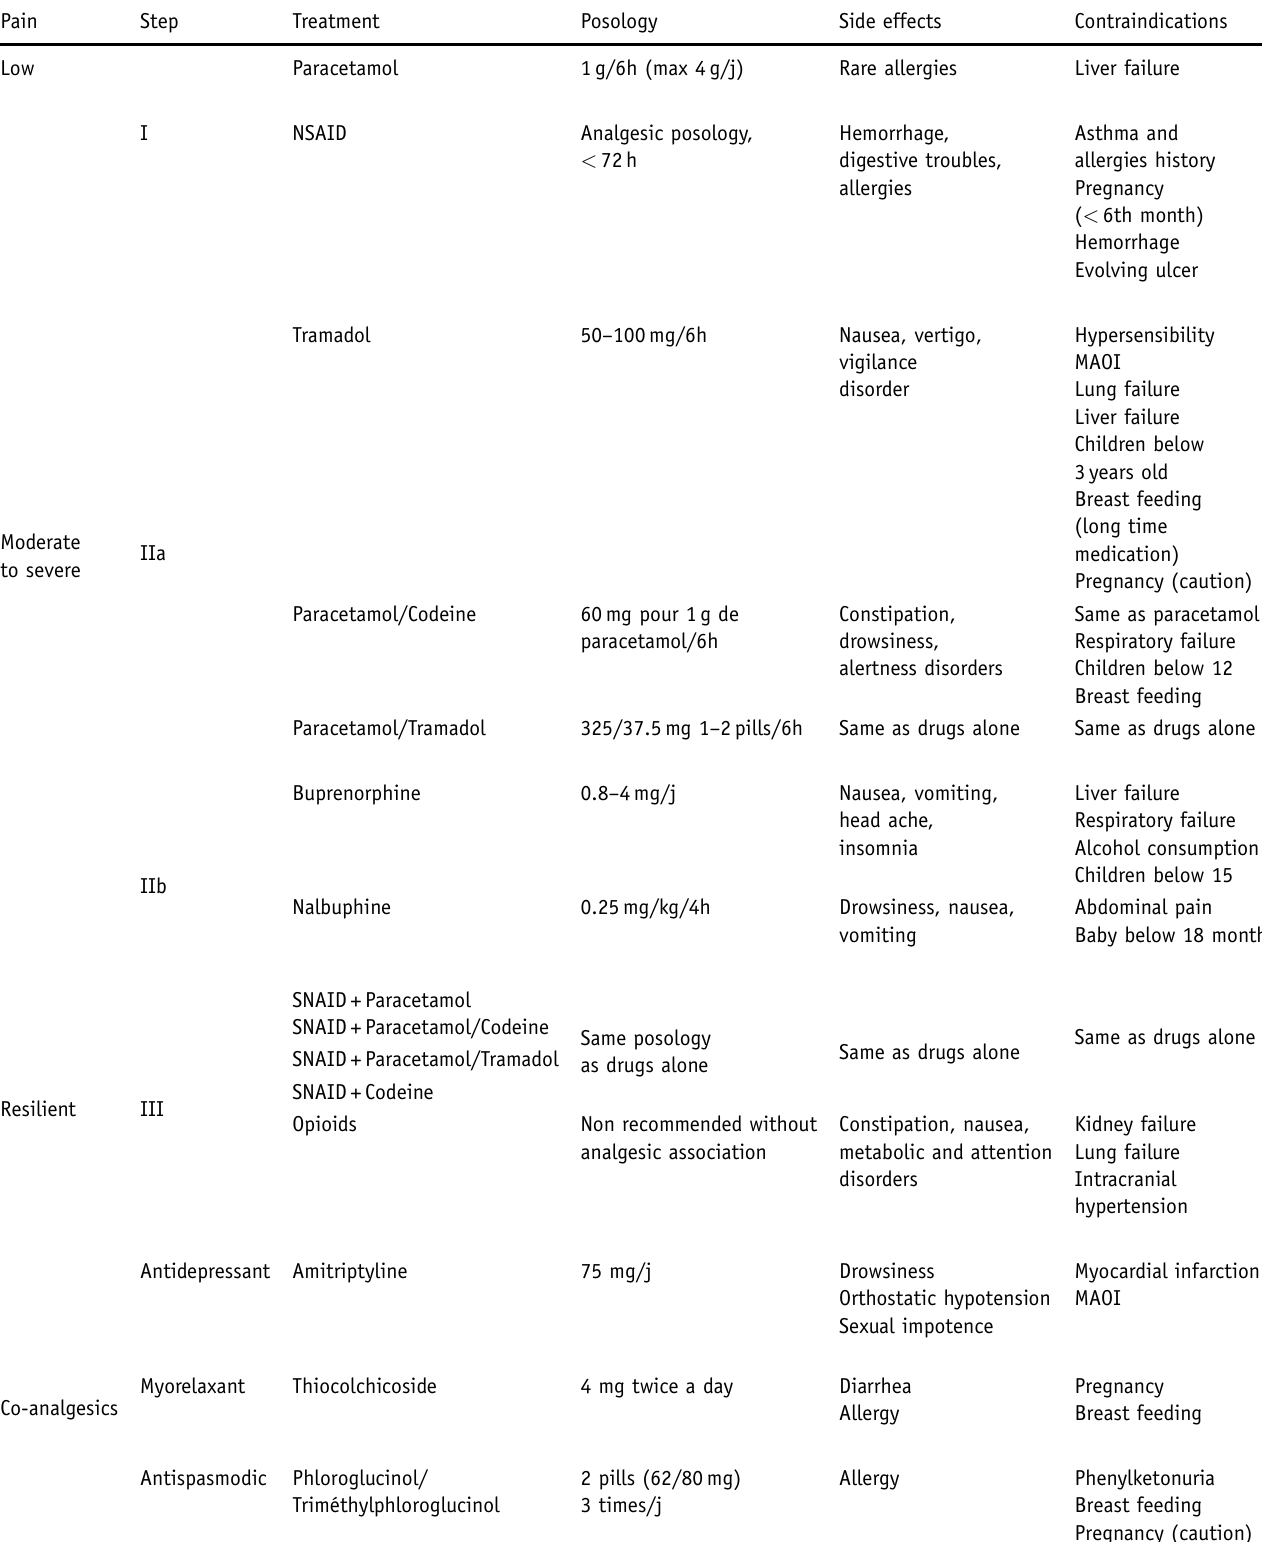
Table 1. Analgesics prescribed in oral surgery according to the pain intensity, their side effects and their